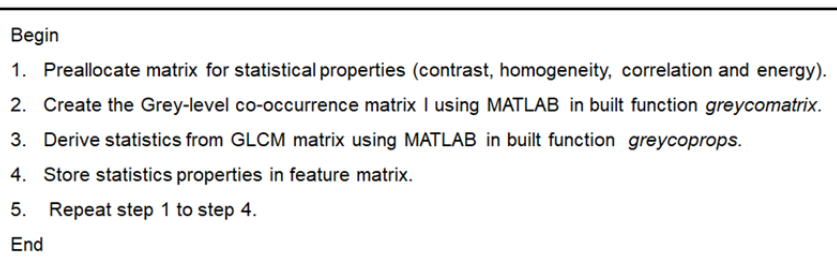
Figure A3. Computation of feature vectors from co-occurrence matrix.